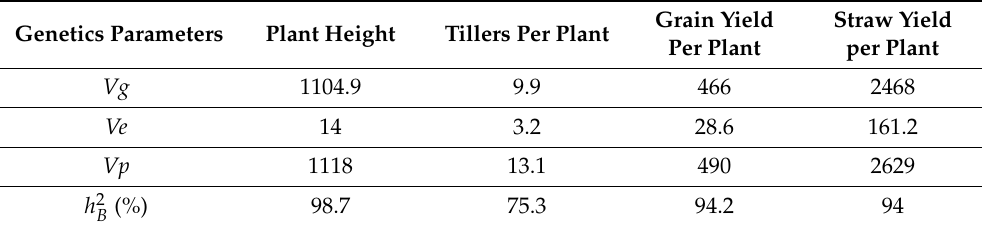
Table 4. Estimation of genetic parameters in rice genotypes for yield and yield-related traits. Genetics